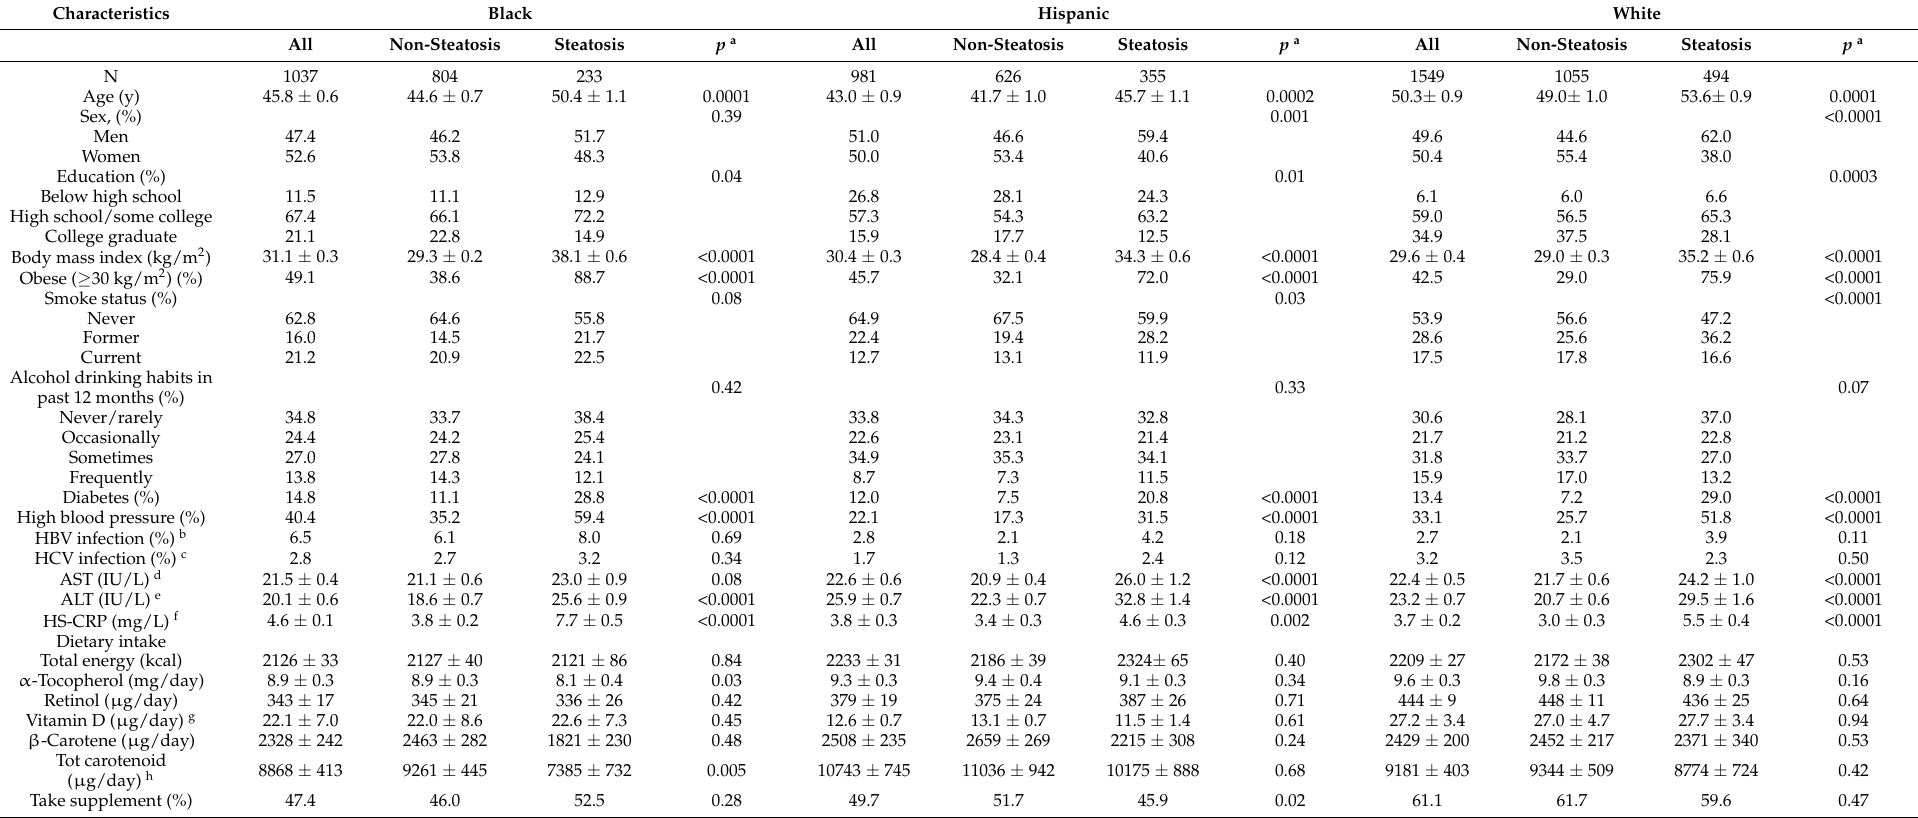
Table 1. Characteristics of Study Participants by Hepatic Steatosis Status and